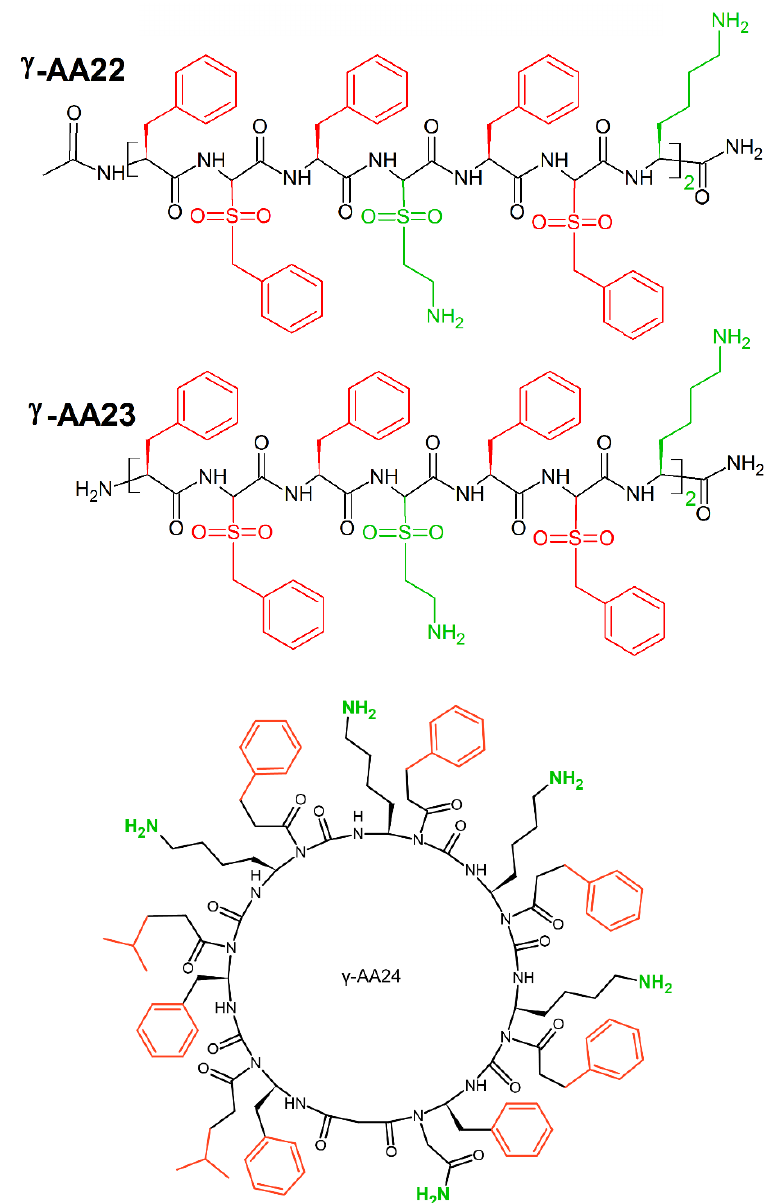
Figure 26. Chemical structures of linear γ - AA16, γ - AA22, γ - AA23 and cyclin γ -AA16 peptides. In green: positively charged amino acids; in red: hydrophobic amino acids.